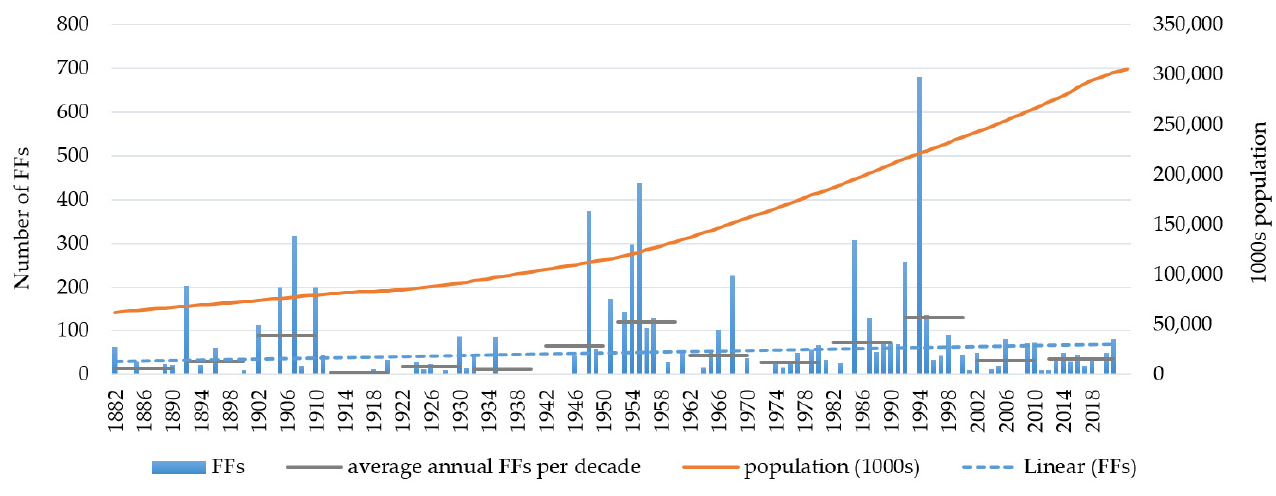
Figure 4. Annual number of flood fatalities (FFs) for the period